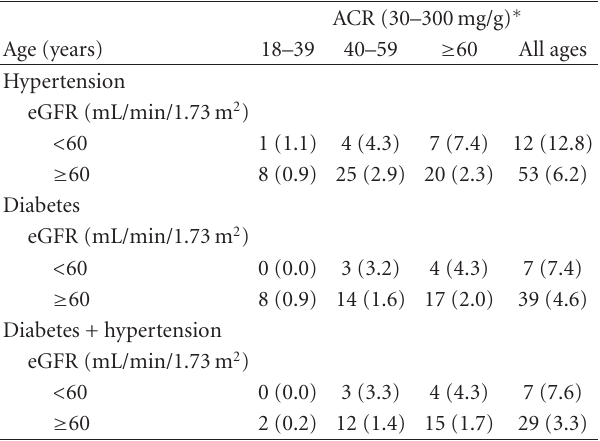
Table 4: Prevalence of microalbuminuria in participants with hypertension or DM according to age groups and level of renal